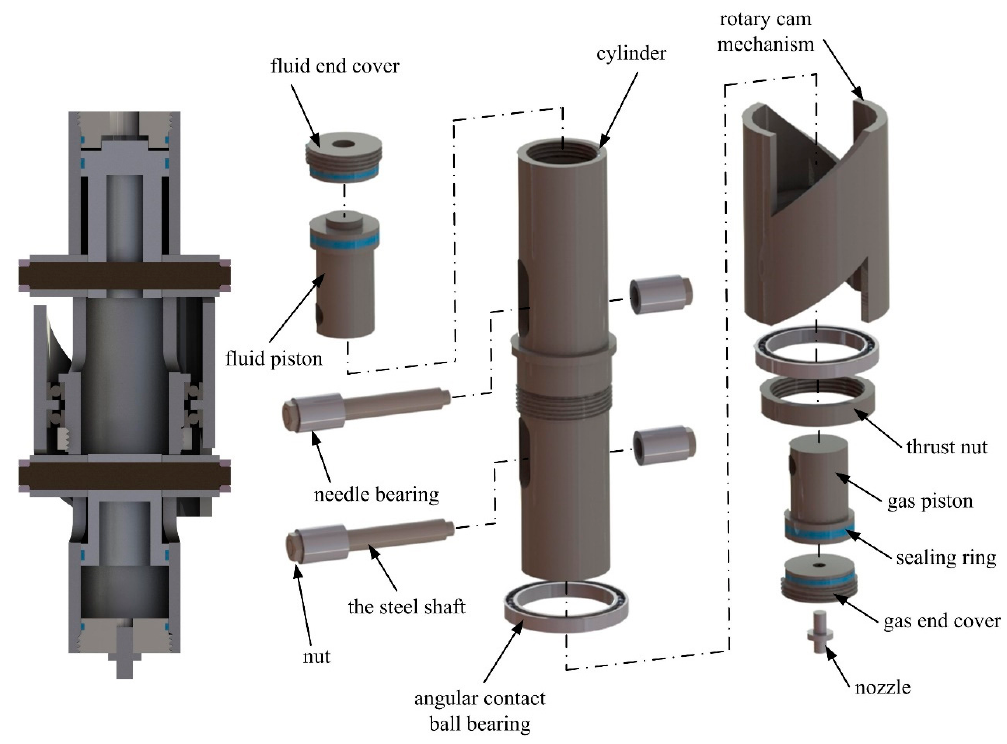
Figure 3. Mechanism structure of the new accumulator.